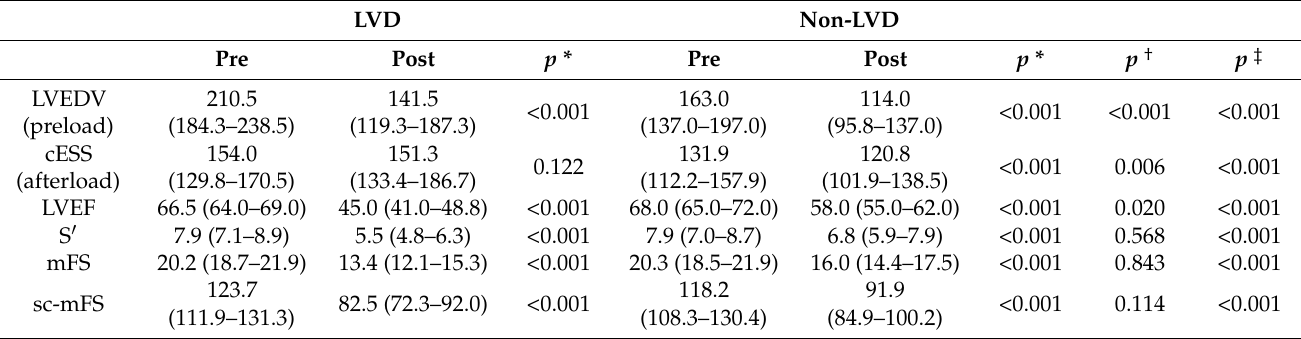
Table 3. Differences in echocardiographic findings between preoperative and immediately after mitral valve